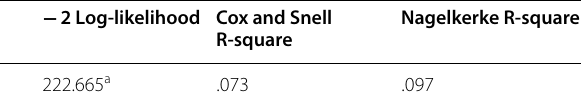
Table R: Model summary for stability culture